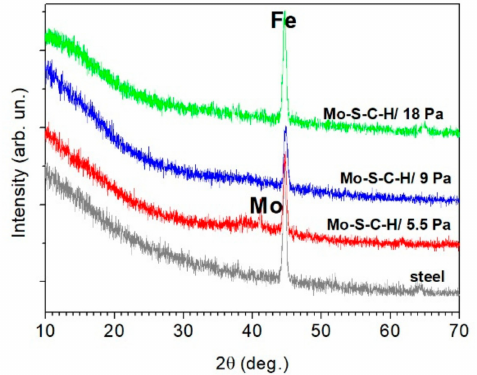
Figure 4. In plane grazing incidence X-ray di ff raction patterns of Mo-S-C-H thin-film coatings obtained on steel substrates by the reactive PLD at various pressures of H 2 S gas. For comparison, X-ray di ff raction pattern for the bare steel substrate is shown.